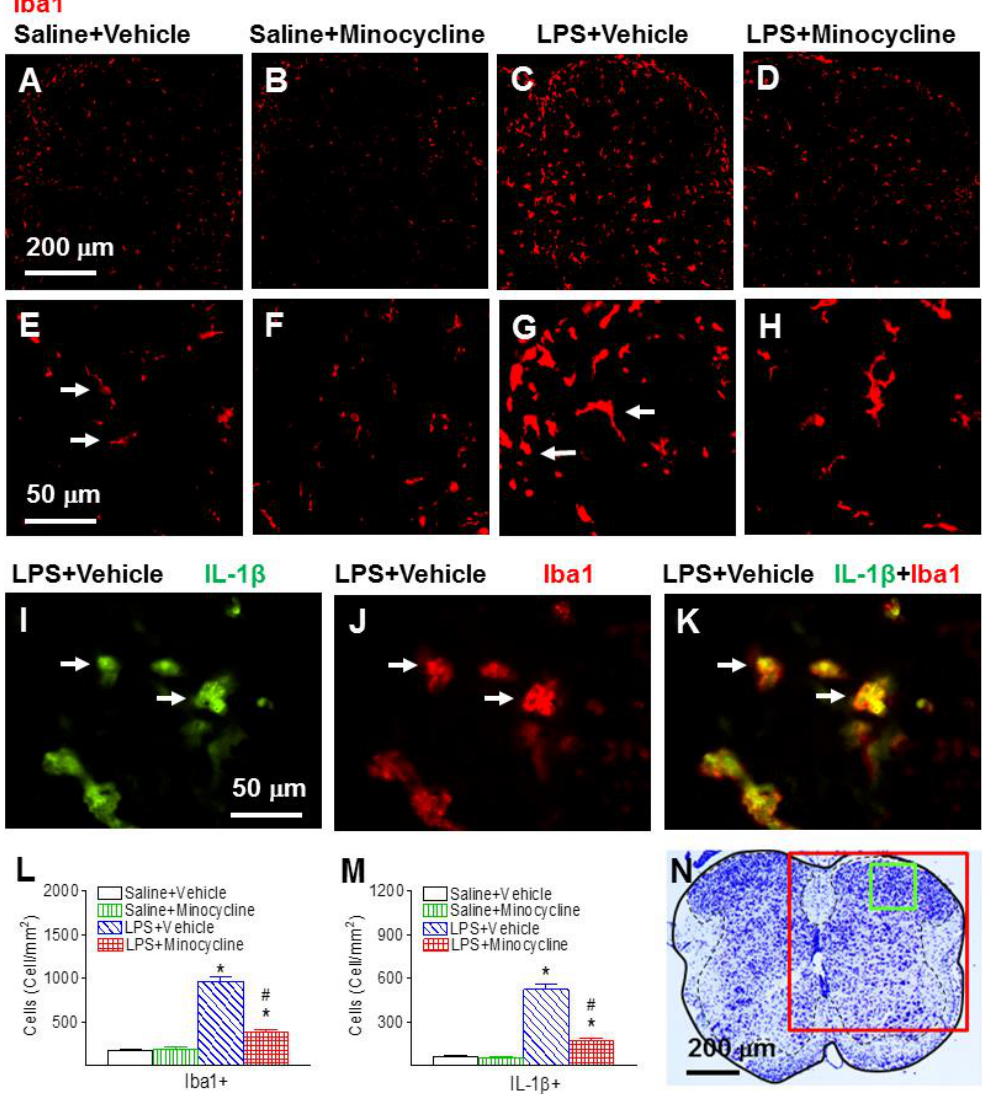
Figure 3. Minocycline reduced neonatal LPS-induced microglia activation, as assessed by ionized calcium binding adapter molecule 1 (Iba1+) staining in the spinal dorsal horn of the P6 rats. The scheme used a Nissl staining section ( N ) presenting an overview over the detected region: red box, ( A – D ); green box, ( E – K ). Representative photomicrographs of Iba1 immunostaining ( A – H ) in the rat